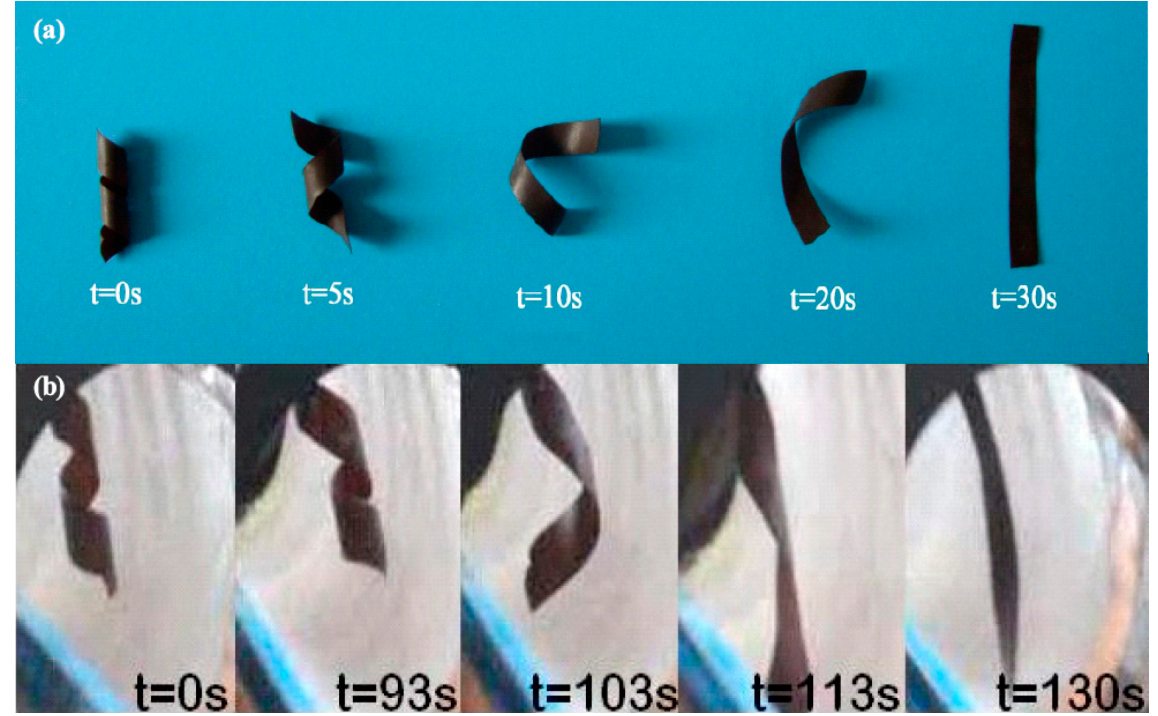
Figure 3. (above, ( a )) The shape memory effect activated in a heated environment (hot water), (below ( b )) the shape memory effect remotely activated by an alternating magnetic fields [23] .